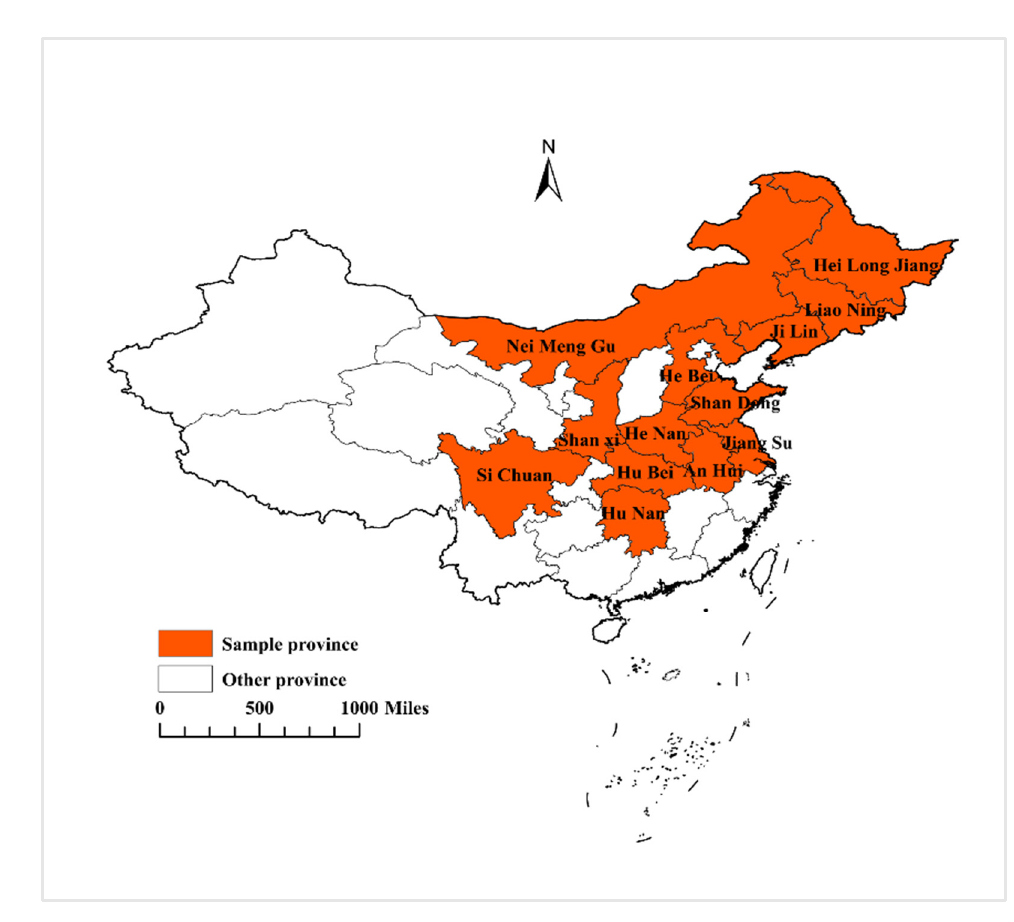
Figure 2. Map of the study area.